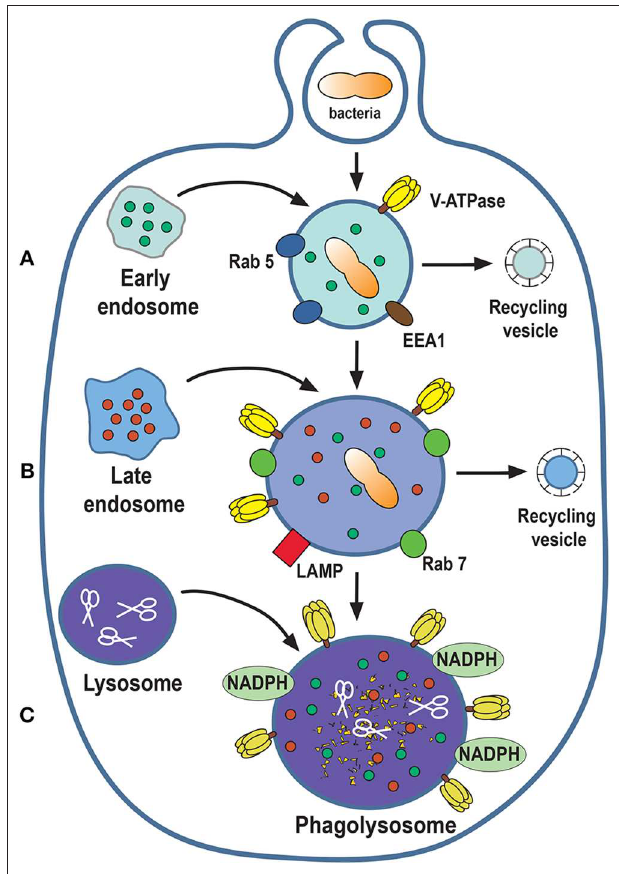
FIGURE 6 | Phagosome maturation. The nascent phagosome gets transformed into a microbicidal vacuole, the phagolysosome, by sequential interactions with vesicles from the endocytic pathway. The process can be described in three stages of maturation: early (A) , late (B) , and phagolysosome (C) . In this process, composition of the membrane changes to include molecules that control membrane fusion, such as the GTPases Rab5 and Rab7. The phagolysosome becomes increasingly acidic by the action of a proton-pumping V-ATPase and acquires various degradative enzymes, such as cathepsins, proteases, lysozymes, and lipases (scissors). EEA1, early endosome antigen 1; LAMP, lysosomal-associated membrane protein; NADPH, nicotinamide adenine dinucleotide phosphate